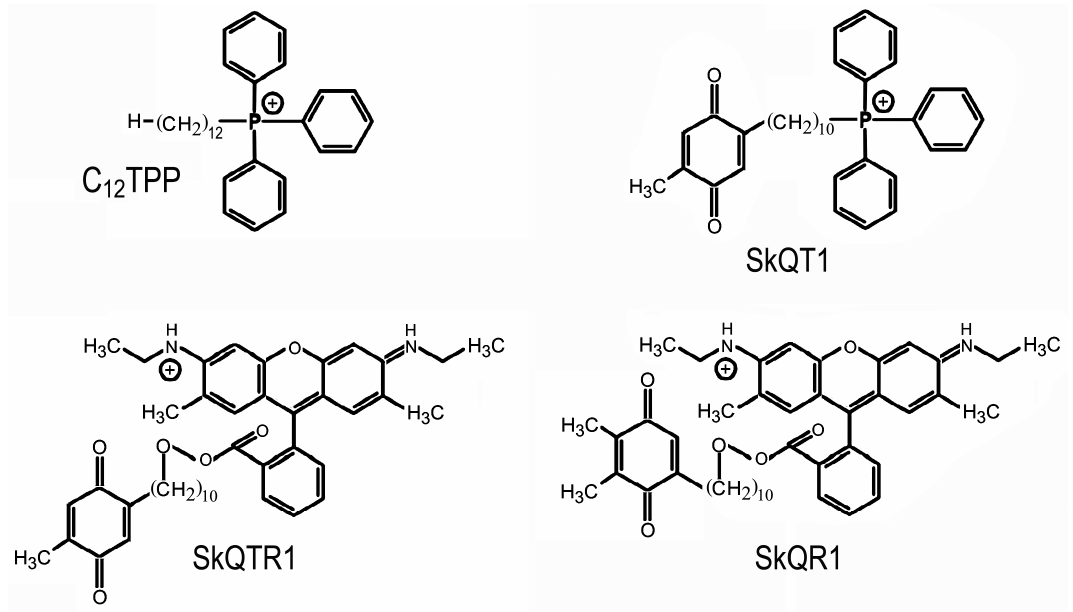
Figure 2. Structure of SkQR1, 10-(6 ′ -plastoquinonyl)decylrhodamine 19; SkQT1, (a mixture of 10-(6 ′ -toluquinonyl)decyltriphenylphosphonium and 10-(5 ′ -toluquinonyl)decyltriphenylphosphonium in the proportion of 1.4:1); SkQTR1, 10-(6 ′ -toluquinonyl)decylrhodamine 19; C12TPP, dodecyltriphenylphosphonium.